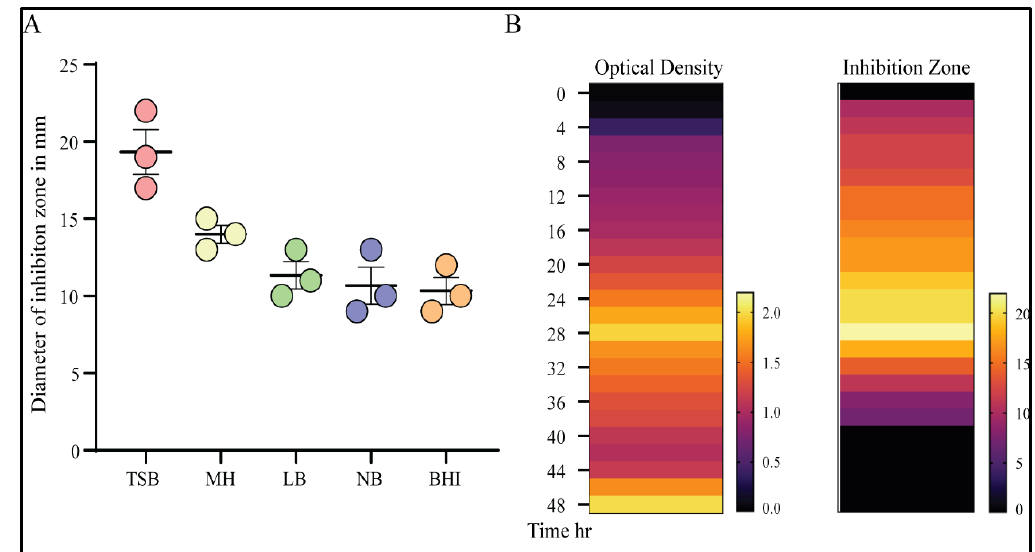
Figure 4. Kinetics of antibiotic production: ( A ) The bacterial isolate was grown in different media (TSB, MH, LB, NB, and BHI). Each supernatant was then filtered, anti-MRSA activity was assayed using the well diffusion method, and the diameter of the zone of inhibition was measured in millimeters after 48 h of incubation. Three independent biological replicates were performed. ( B ) Heat maps depicting kinetics of bacterial growth in TSB media and corresponding antibiotic productivity dictated by measuring the zone of inhibition over time for 48 h.